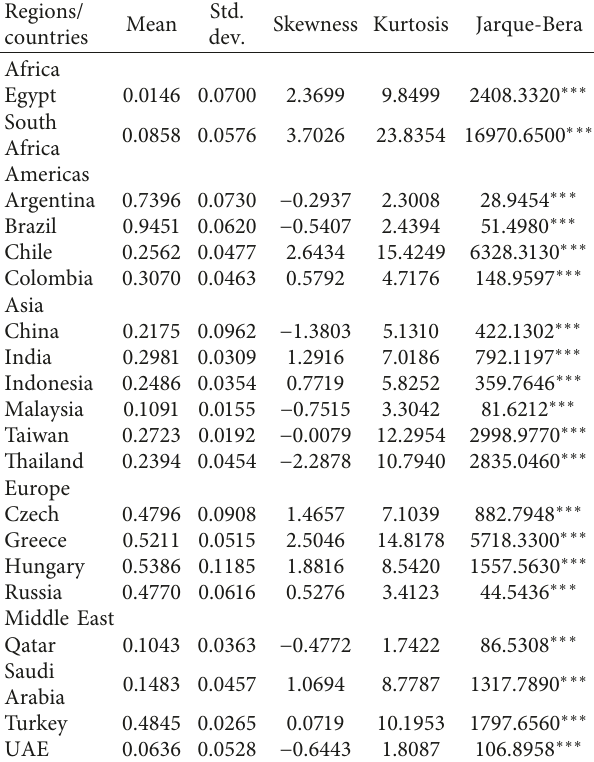
Table 2: Descriptive statistics of equity beta